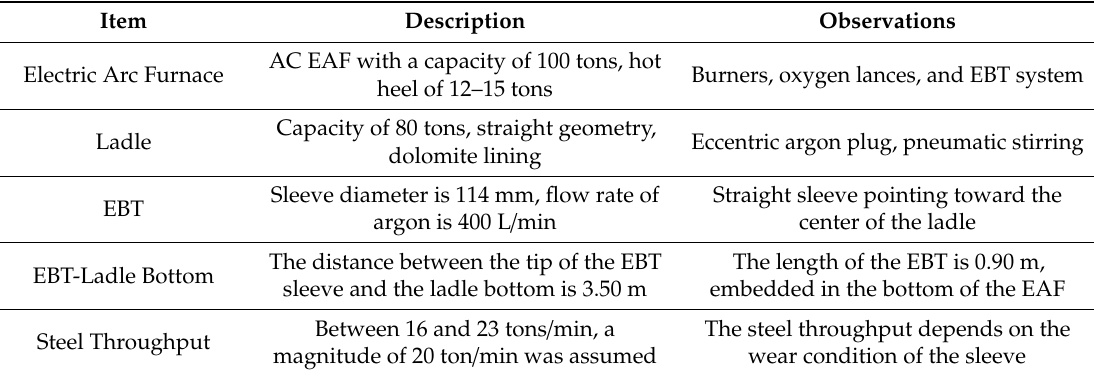
Table 1. Tapping conditions of liquid steel from furnace to ladle.